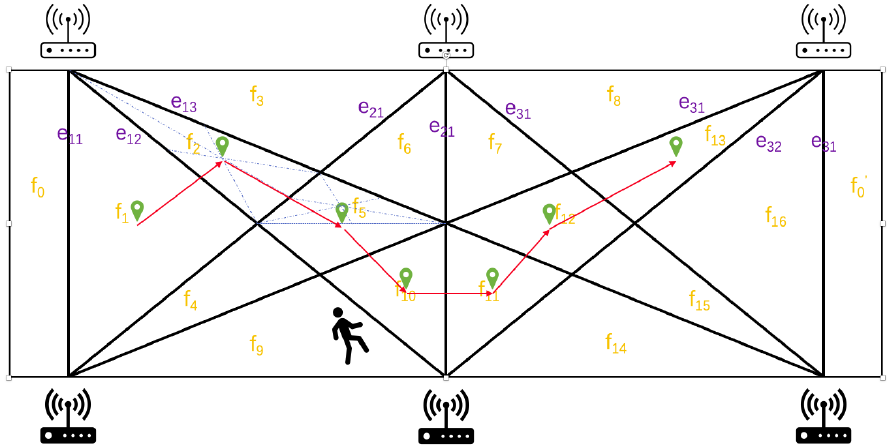
Figure 13. Schematic of the Rapid Passive Device-Free